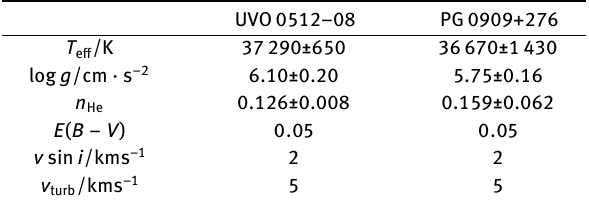
Table 2. Atmospheric